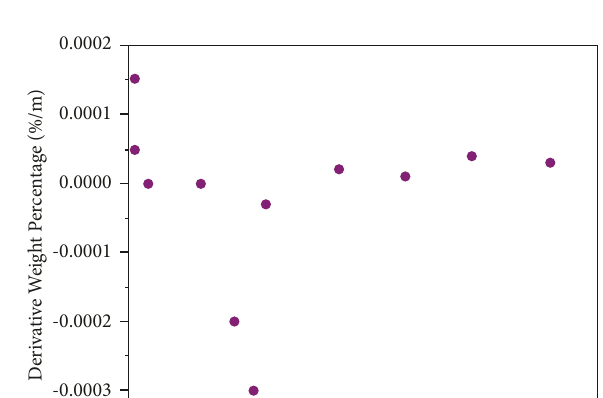
Figure 3: TGA of TiC NPs.